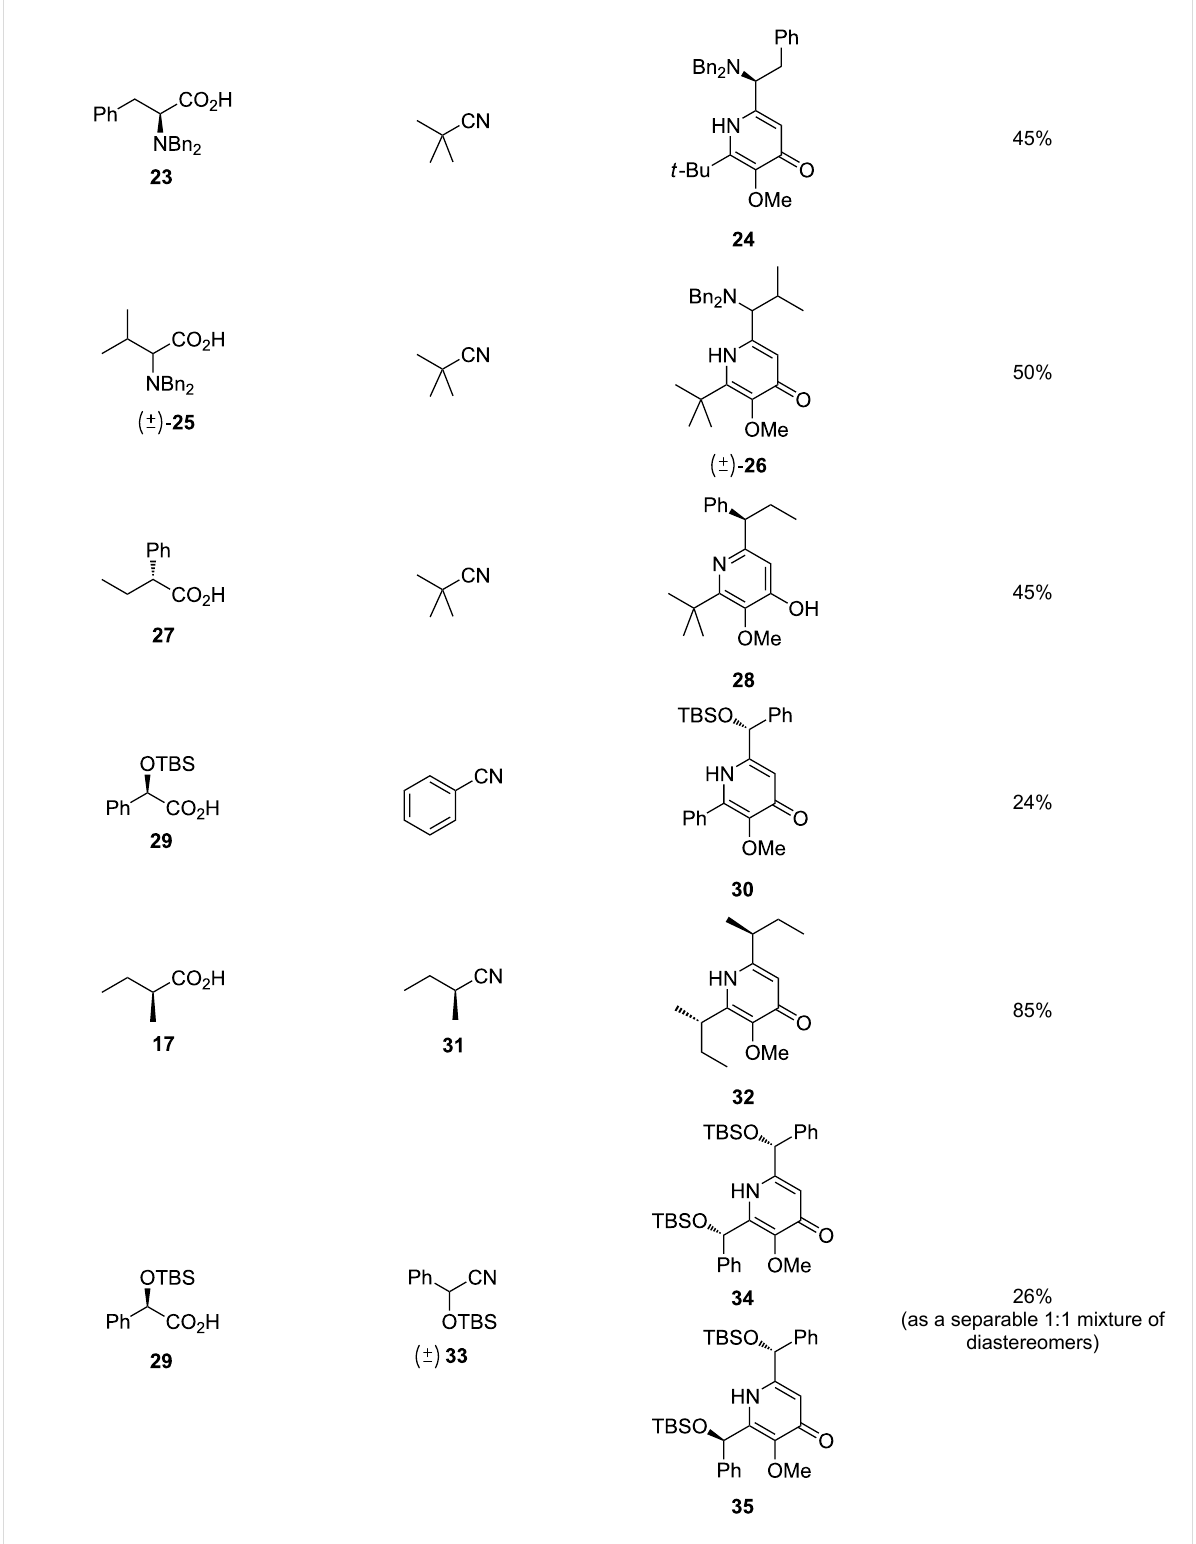
Table 1: Scope of the synthesis of 4-hydroxypyridine derivatives from lithiated methoxyallene, nitriles and carboxylic acids.